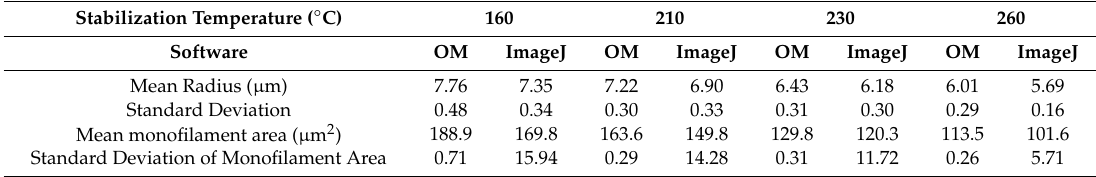
Table 5. Synopsis of alternation of PAN cross-sectional area investigation results through optical microscopy